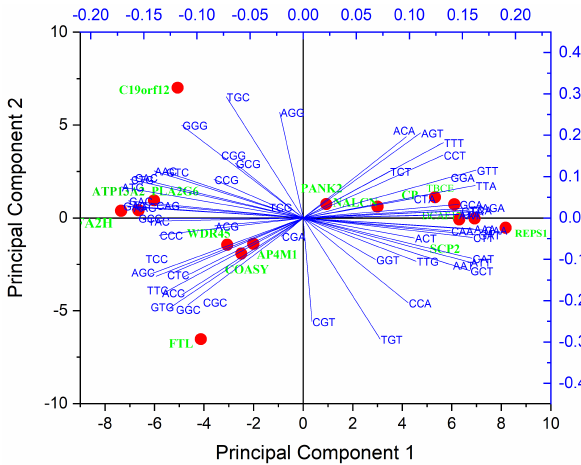
Fig. 9. PCA analysis of a set of genes involved in brain degeneration associatedwithironaccumulation. Thegeneshavebeenshownwiththe red color font. Each red dot represents the position of a gene. The codons havebeendepictedwiththebluecolorfont. C19orf12 and FTL genesshowed a distinct codon usage pattern from other genes. The remaining genes scat- tered around X-axis indicated not much variation in their RSCU